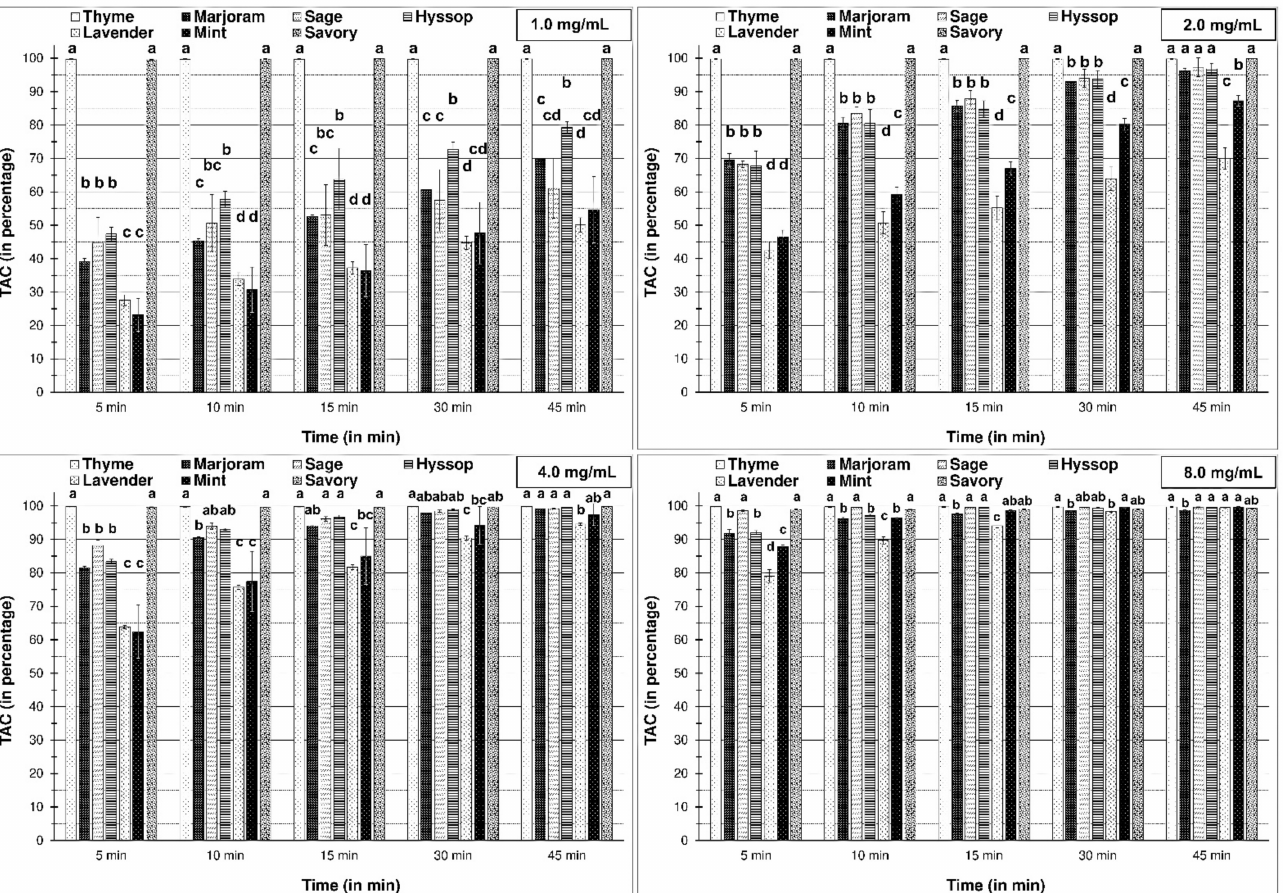
Figure 3. Total antioxidant capacity (in the percentage of scavenging) of examined essential oils against ABTS • + radical; 1.0, 2.0, 4.0, 8.0 mg/mL are concentration of essential oils in the reaction mixtures. The bars for each time period marked by different letters are statistically different at p < 0.05 (Tukey’s